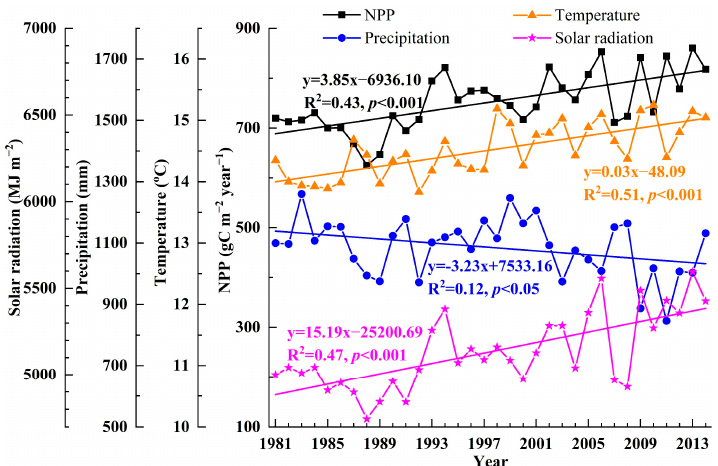
Figure 4. Interannual change trends in cropland ecosystem NPP, temperature, precipitation, and solar radiation from 1981 to 2014 across the entire study area.